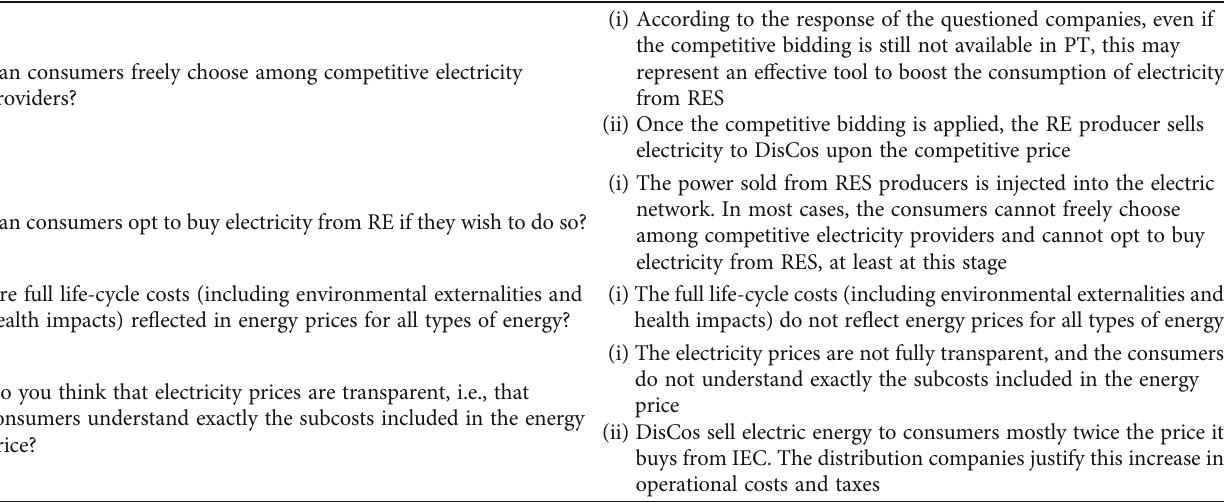
Table 6: Summarization of the answers of public institutions related to electricity consumption.